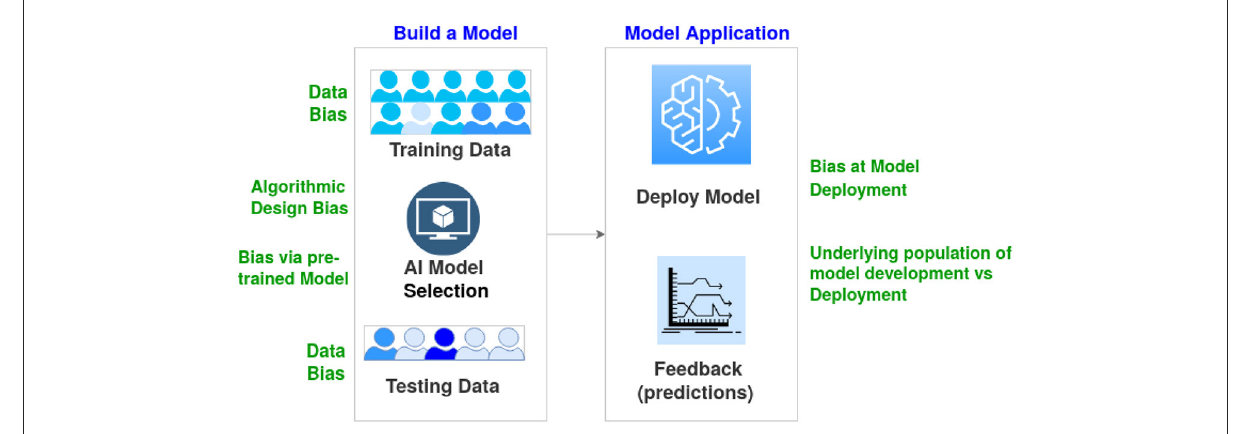
FIGURE1 Overview describing the basic stages of AI model development and deployment. Examples of bias at various stages are